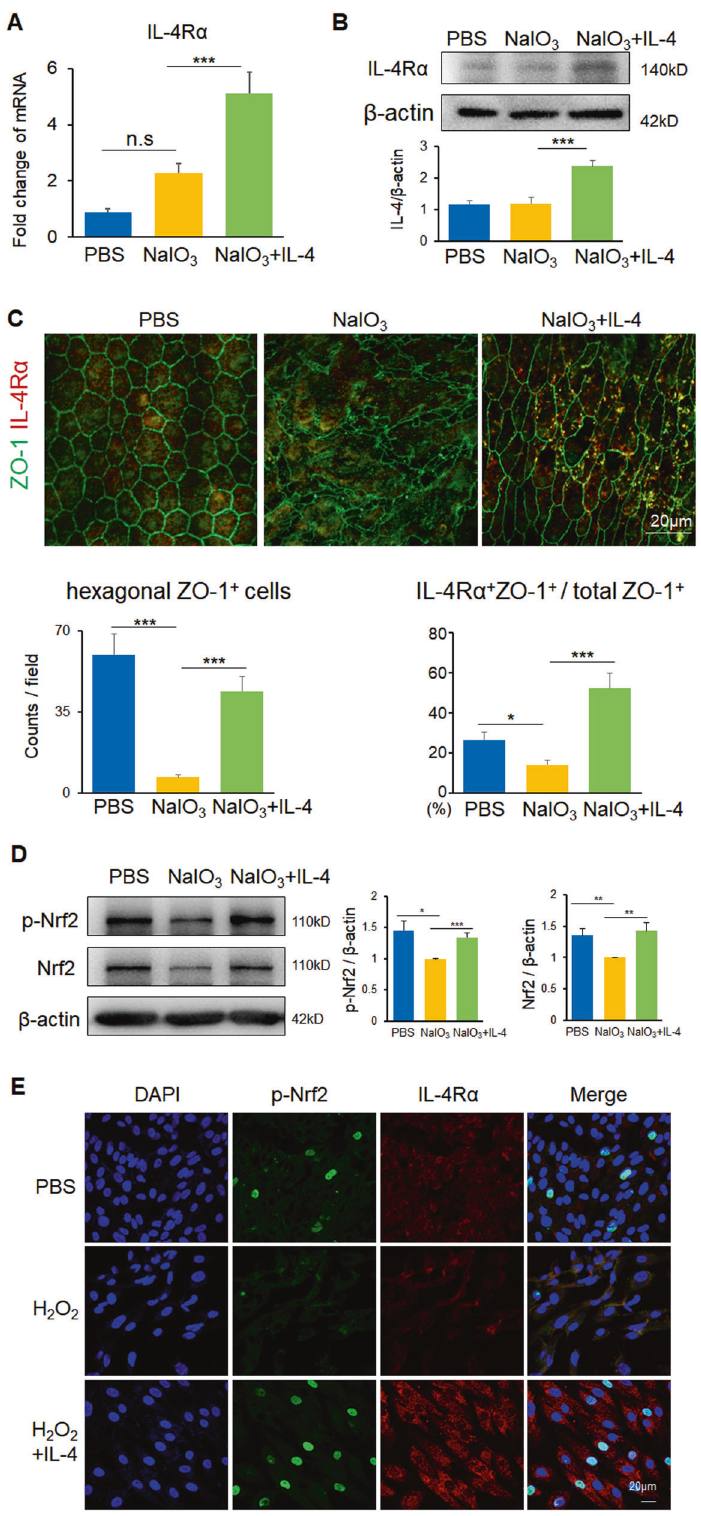
Fig. 4 IL-4R and Nrf2 activation in response to IL-4 in vivo and in vitro. A , B qPCR ( A ) and western blotting analysis ( B ) showed elevated IL- 4Ra expression in RPE complex from the NaIO 3 -induced degenerative mice after IL-4 treatment. n = 3. C Representative images of RPE fl at-mount sheet revealed that increased IL-4Ra distributed alongside the RPE tight junction marker ZO-1. Scale bar: 20 μ m. The hexagonal ZO-1 + cells per fi eld and the percentage of IL-4R α + ZO-1 + cells and total ZO-1 + cells were calculated for statistics. D Western blotting analysis showed reduction of total and phosphorylated Nrf2 expression in NaIO 3 model, while IL-4 treatment induced their elevations. n = 3. E Representative images of cultured RPE cells under oxidative stress insults showing lack of IL-4R α and phosphorylated Nrf2 expression, which were induced after IL-4 stimulation. Data are shown as mean ± SEM, * P < 0.05, ** P < 0.01, *** P < 0.001, n.s: no signi fi cance, one-way ANOVA test.